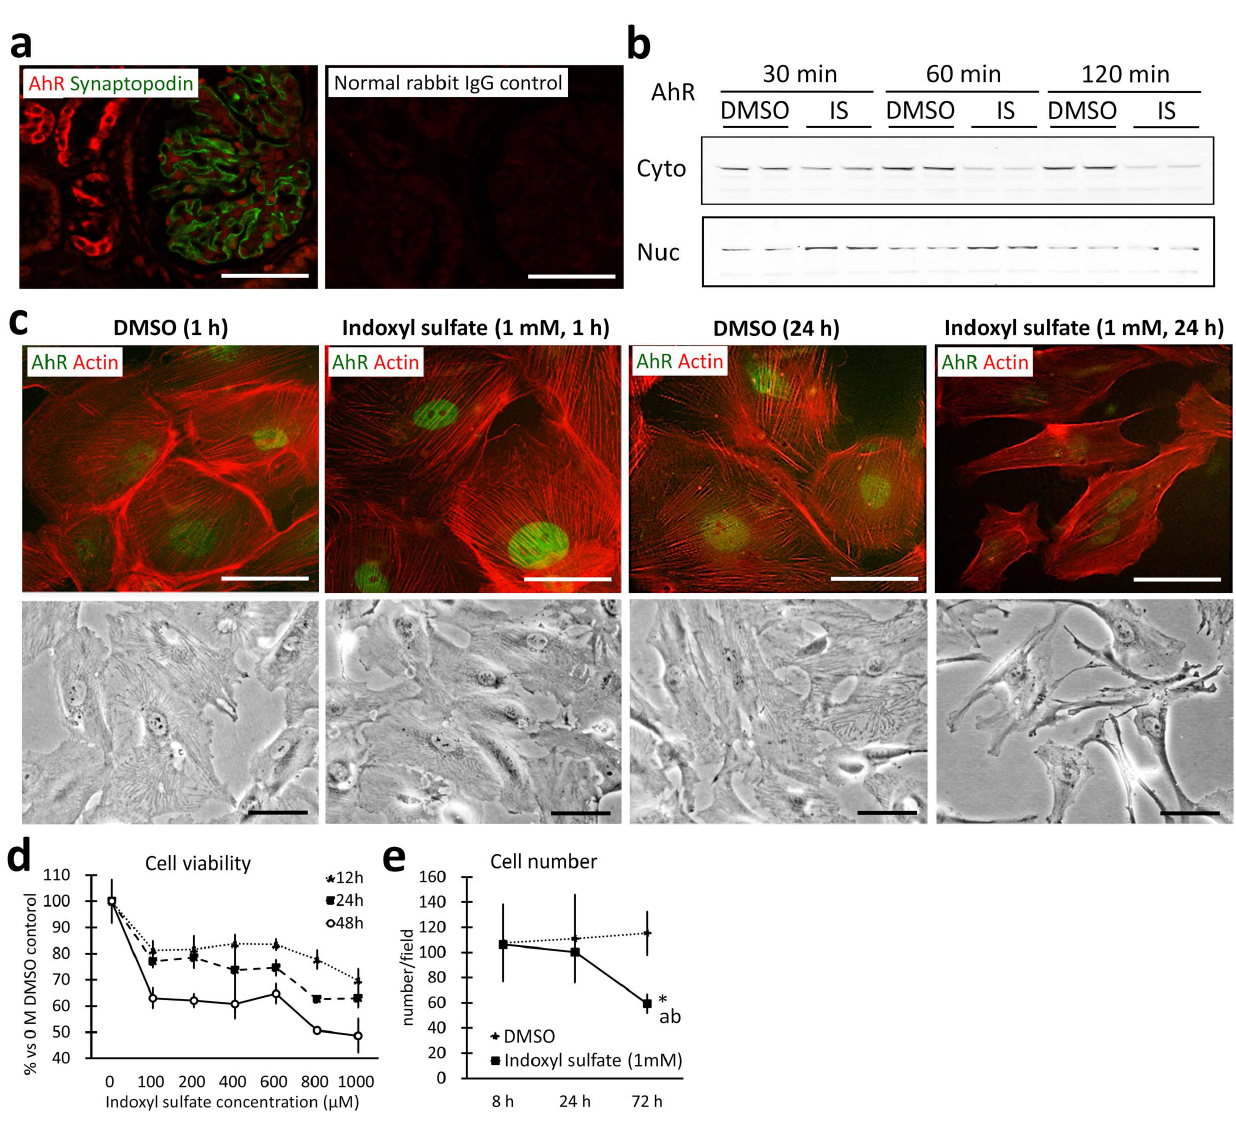
Figure 7. Indoxyl sulfate injures human podocytes. Immunofluorescence images of autopsied human kidneys shows juxtaposition of AhR in podocyte nuclei surrounded by cytoplasm expressing synaptopodin ( a ). AhR (red), synaptopodin (green), and normal rabbit IgG control. Immunoblotting for AhR in differentiated human podocytes demonstrates nuclear translocation following indoxyl sulfate exposure ( b ). Cyto denotes cytoplasmic protein, Nuc denotes nuclear protein extracted from dimethyl sulfoxide (DMSO)- or indoxyl sulfate (IS)-treated human podocytes. Each lane contained 20 m g of protein. Immunofluorescence and phase-contrast images of differentiated human podocytes exposed to DMSO or indoxyl sulfate for 1 h shows rapid nuclear localization following indoxyl sulfate exposure ( c ). AhR (green). Actin (red, phalloidin staining). Cell viability, assessed using an MTT assay, of indoxyl sulfate-treated differentiated human podocytes was reduced in a dose-dependent and time-dependent fashion compared to DMSO control ( d ). n=3, mean 6 SD. Baseline viability was assessed using a 0 m M control for each time group. Cell numbers were deceased in indoxyl sulfate-treated differentiated human podocytes compared to DMSO control ( e ). n=3, mean 6 S.D. Indoxyl sulfate-treated cells were reduced in number at 72 h compared to DMSO control (*, P , 0.05). Indoxyl sulfate-treated cell numbers were also reduced at 72 h compared to the 8 h (a, P , 0.05) and 24 h (b, P , 0.05) time points.